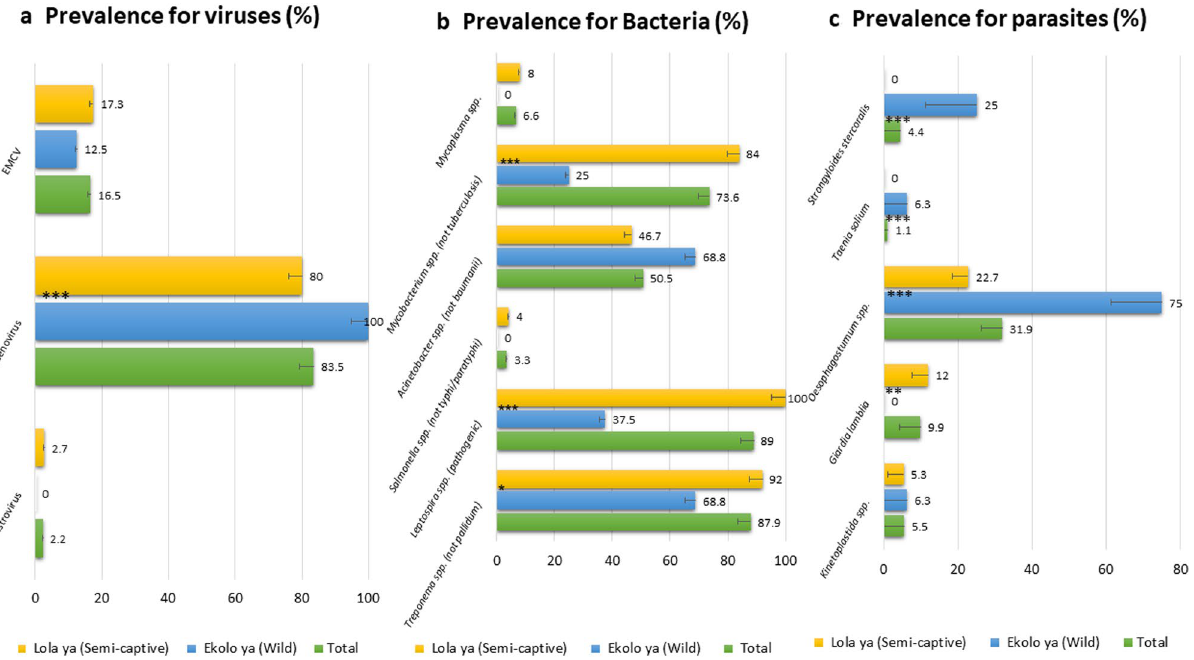
Figure 1. Large screening results; ( a ) Prevalence of viruses; ( b ) Prevalence of Bacteria; ( c ) Prevalence of parasites. ***Significative difference between Lola and Ekolo with p. value < 0.0001. **p. value < 0.03. *p. value < 0.05. Bars represent the error bars for percentages, they are showed by the lower half part of